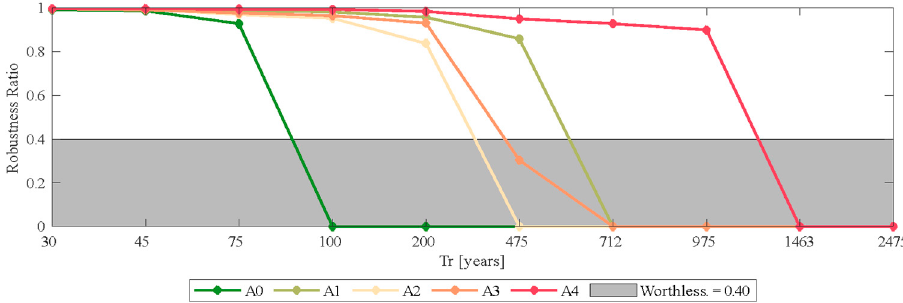
Figure 10. Robustness of the case study school building (A0) and retrofitting alternatives.